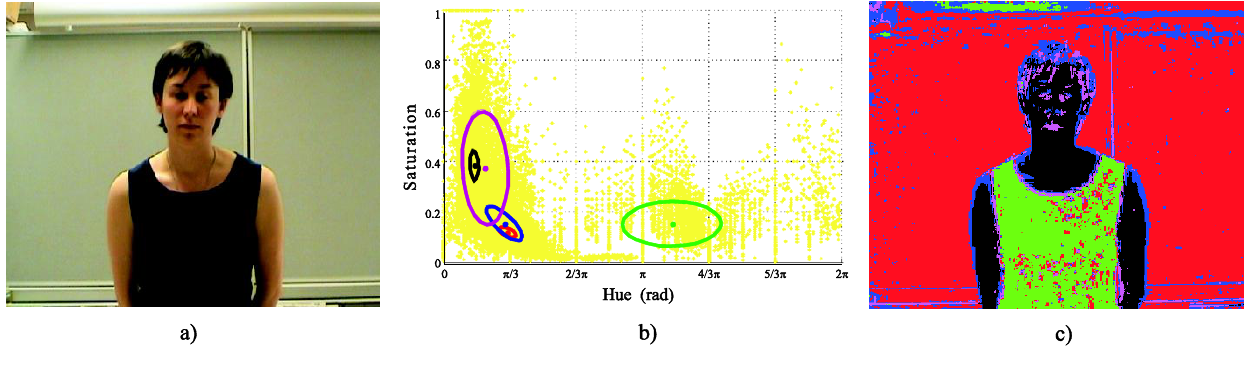
Figure 2. Class segmentation results of the initialization stage. (a) Initial image, (b) the K Gaussians fitted to the classes projected in the HS plane, (c) segmented image opt corresponding with the K classes in the Figure 2b. The colours of the different ellipses opt that represent the Gaussians in the Figure 2b correspond with the colours of the segmented regions in the image of the Figure